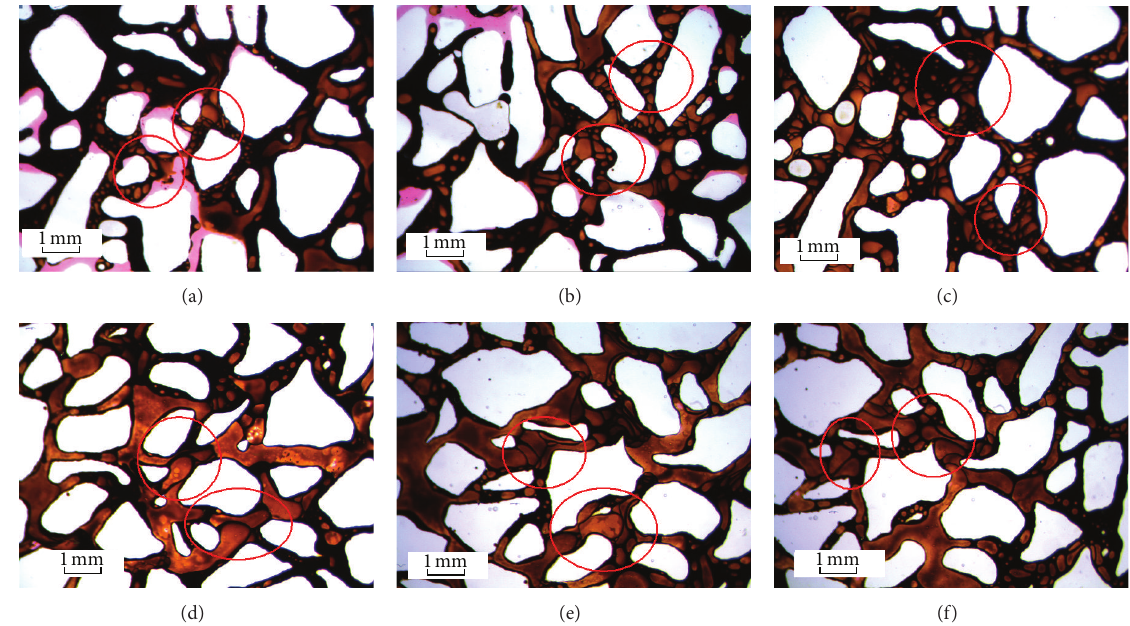
Figure9:Microscopicimagesofalkalinefloodingfordifferenttypesofoilsamples:(a),(b),and(c)Zhuangxiand(d),(e),and(f)Chenzhuang.